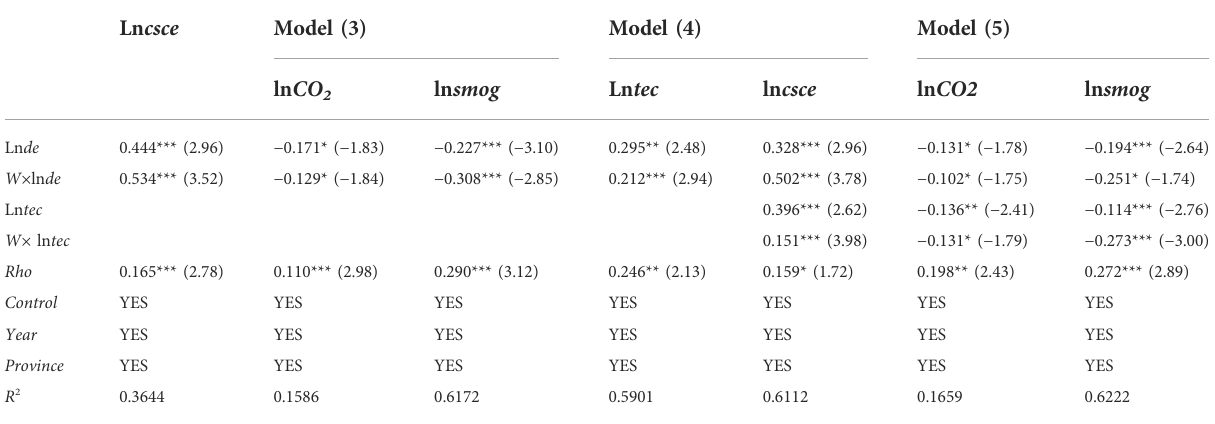
TABLE 7 Regression coef fi cients for the intermediary effects